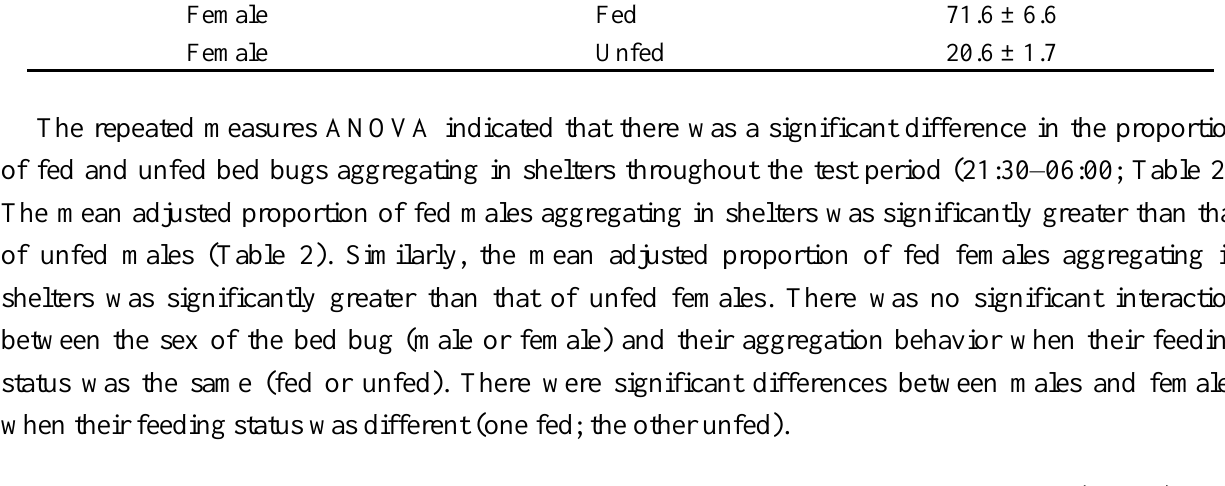
Table 2 . Comparison of treatment interactions for male and female bed bugs ( n =